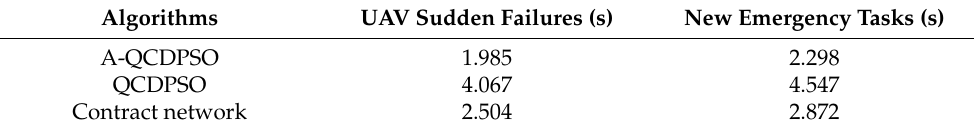
Table 14. Comparison of the average time of three algorithms to obtain the optimal